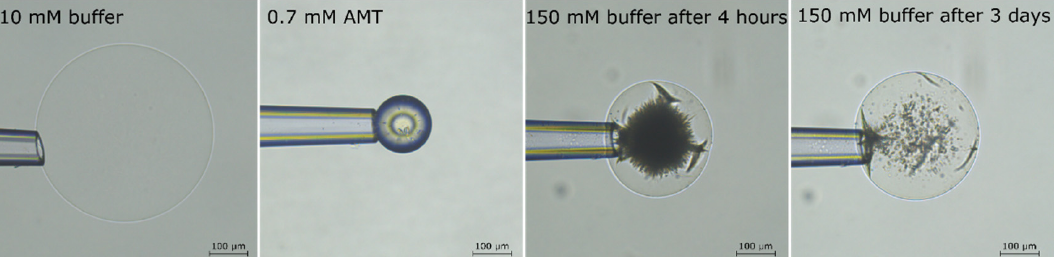
Figure 8. Light microscopy images of a polyacrylate microgel in (from left to right): 10 mM buffer; 0.7 mM AMT solution of 10 mM ionic strength overnight; small volume of AMT solution at 155 mM ionic strength after 4 h and three days, respectively. All pictures show the same microgel